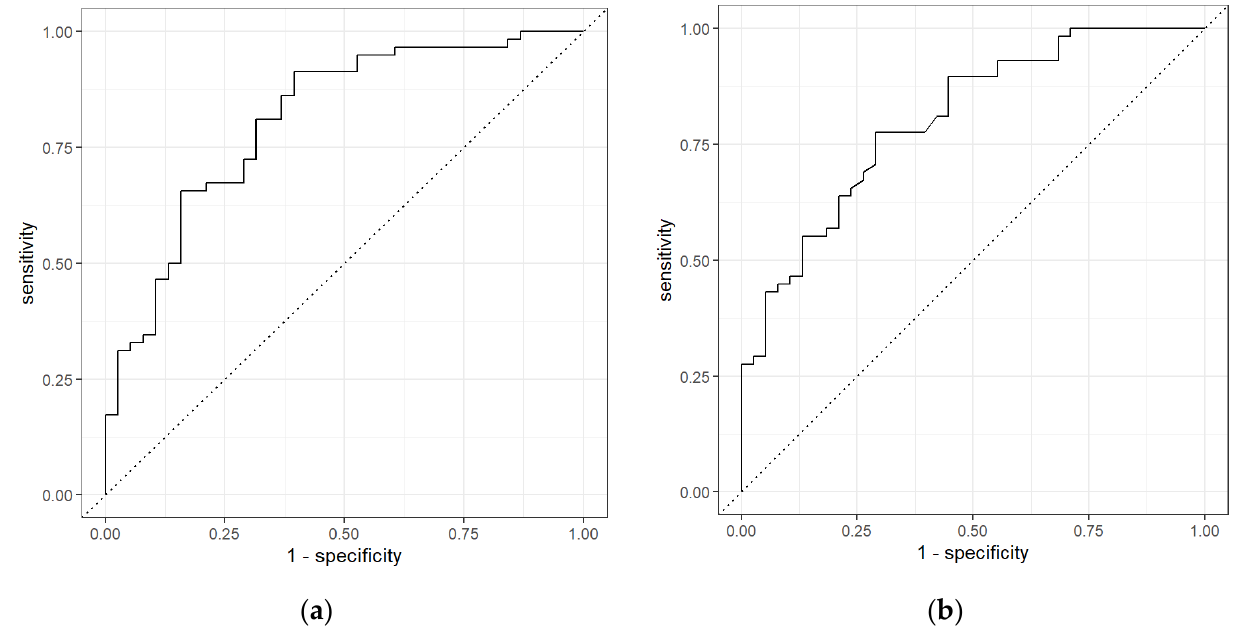
Figure 5. ROC for CRC vs. Non-Cancerous using ( a ) Neural Network and ( b ) Random Forest classifiers for PEN3.